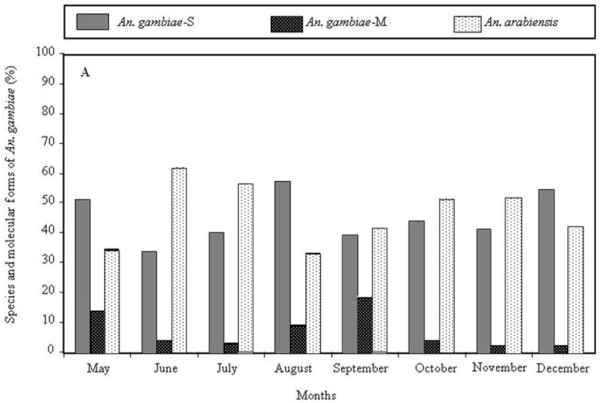
Monthly population dynamics ofAnopheles gambiae s.l.in Kodeni.